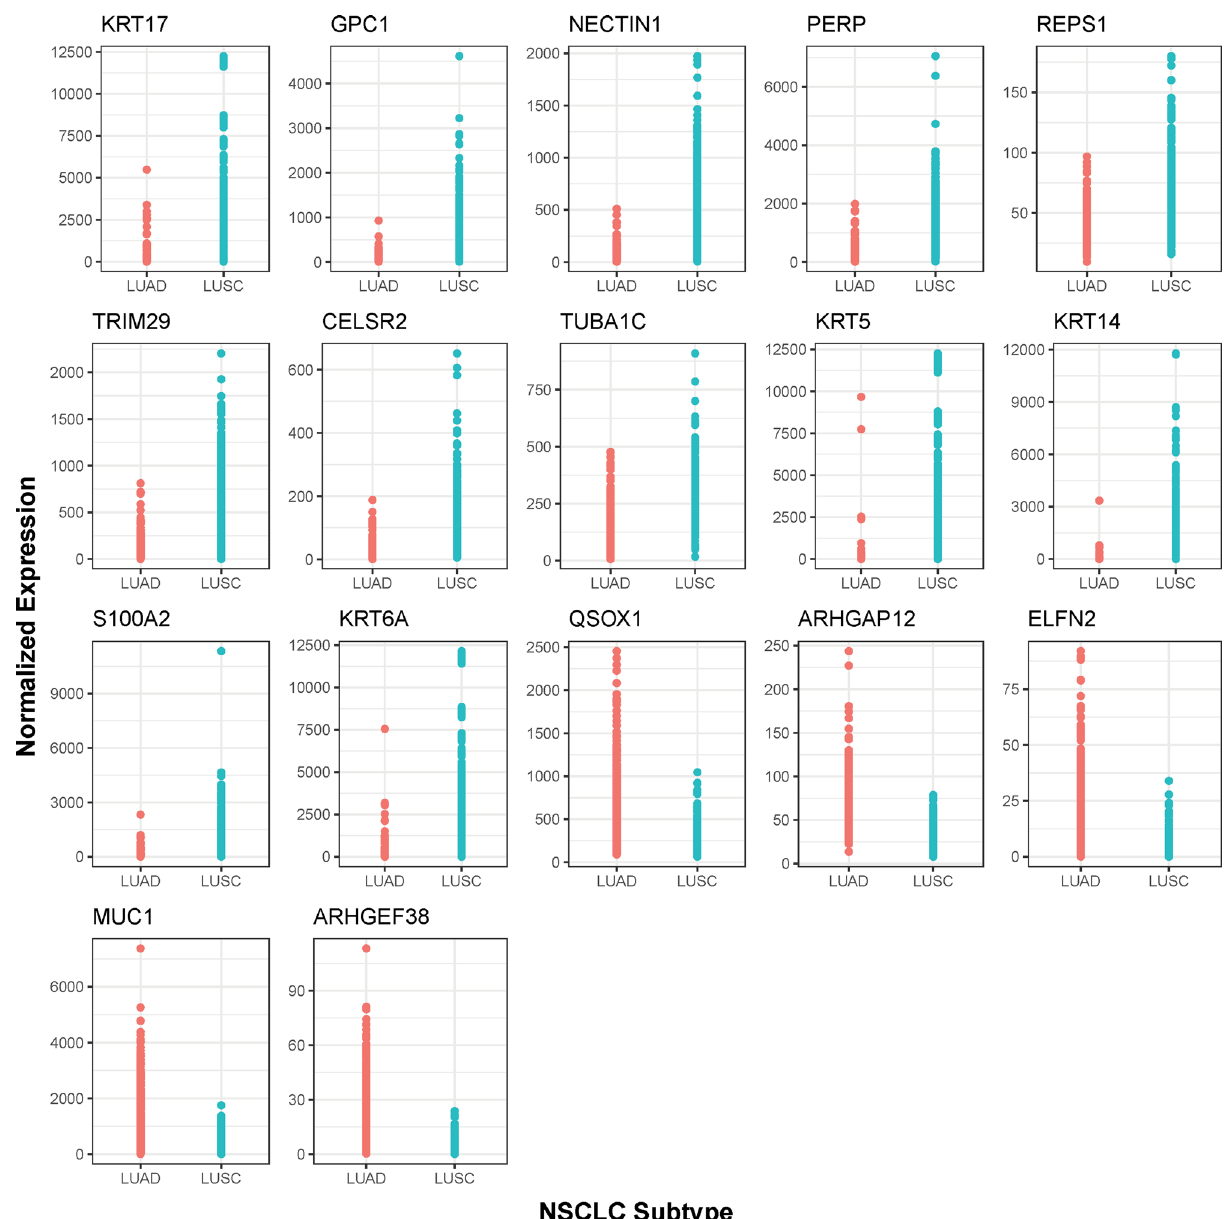
Figure 4. Normalized Gene Expression Distribution Dot Plots for the 17 Biomarker Candidates 87 . The x-axis represents the NSCLC subtypes and the y-axis represents the normalized gene expression